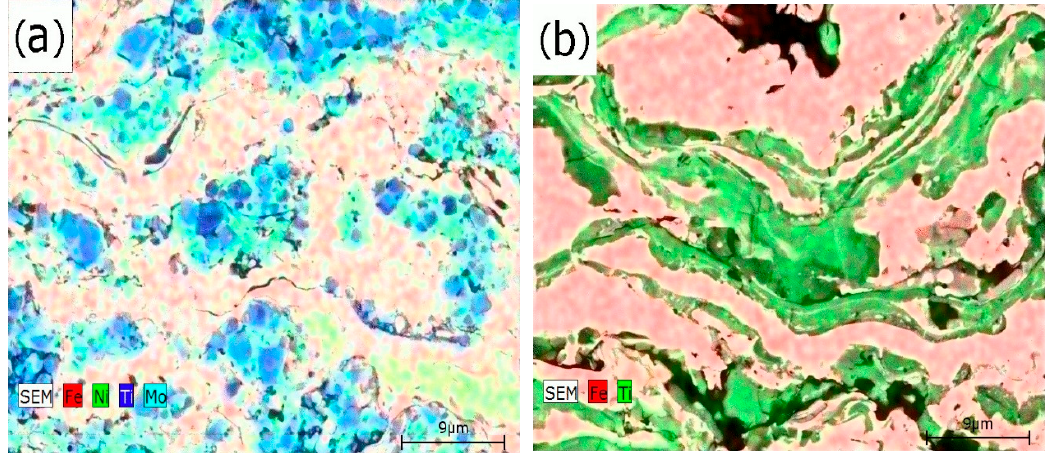
Figure 5. EDS maps of Ti-based coatings: ( a ) MAS (TiC–20%NiMo) + AISI 316L; ( b ) RTS (Ti + C) + AISI 316L.